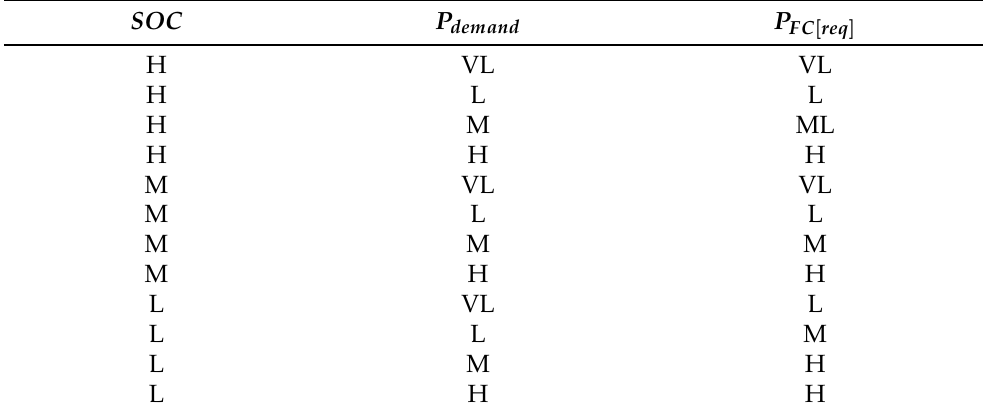
Table 2. Fuzzy logic rules assigned to the